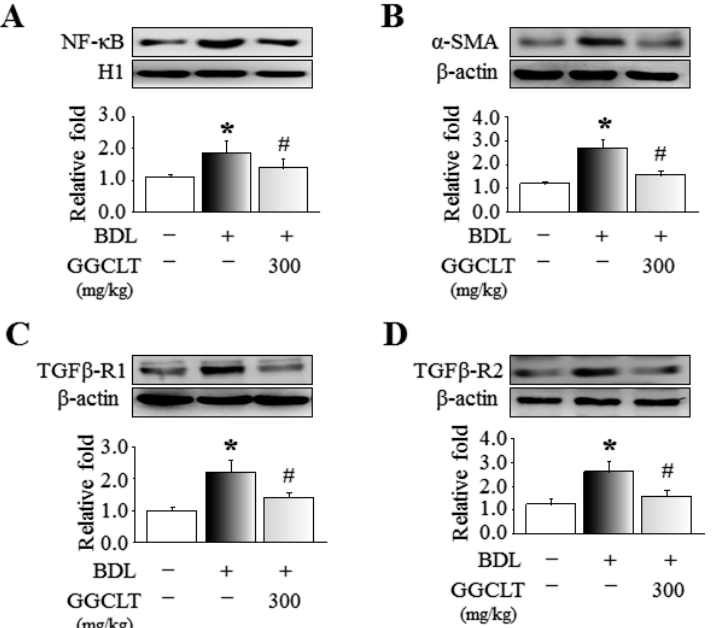
Figure 4. Western blot analysis of hepatic protein levels of (A) nuclear factor kappa B (NF- κ B), (B) α - smooth muscle actin ( α -SMA), (C) transforming growth factor- β (TGF β )-R1 and (D) TGF β -R2 in the liver tissues of sham-control mice and BDL mice treated with or without 300 mg/kg GGCLT. The data presented are the mean ± SEM from three independent measurements. * p < 0.05 vs. sham-control mice; # p < 0.05 vs. BDL mice.